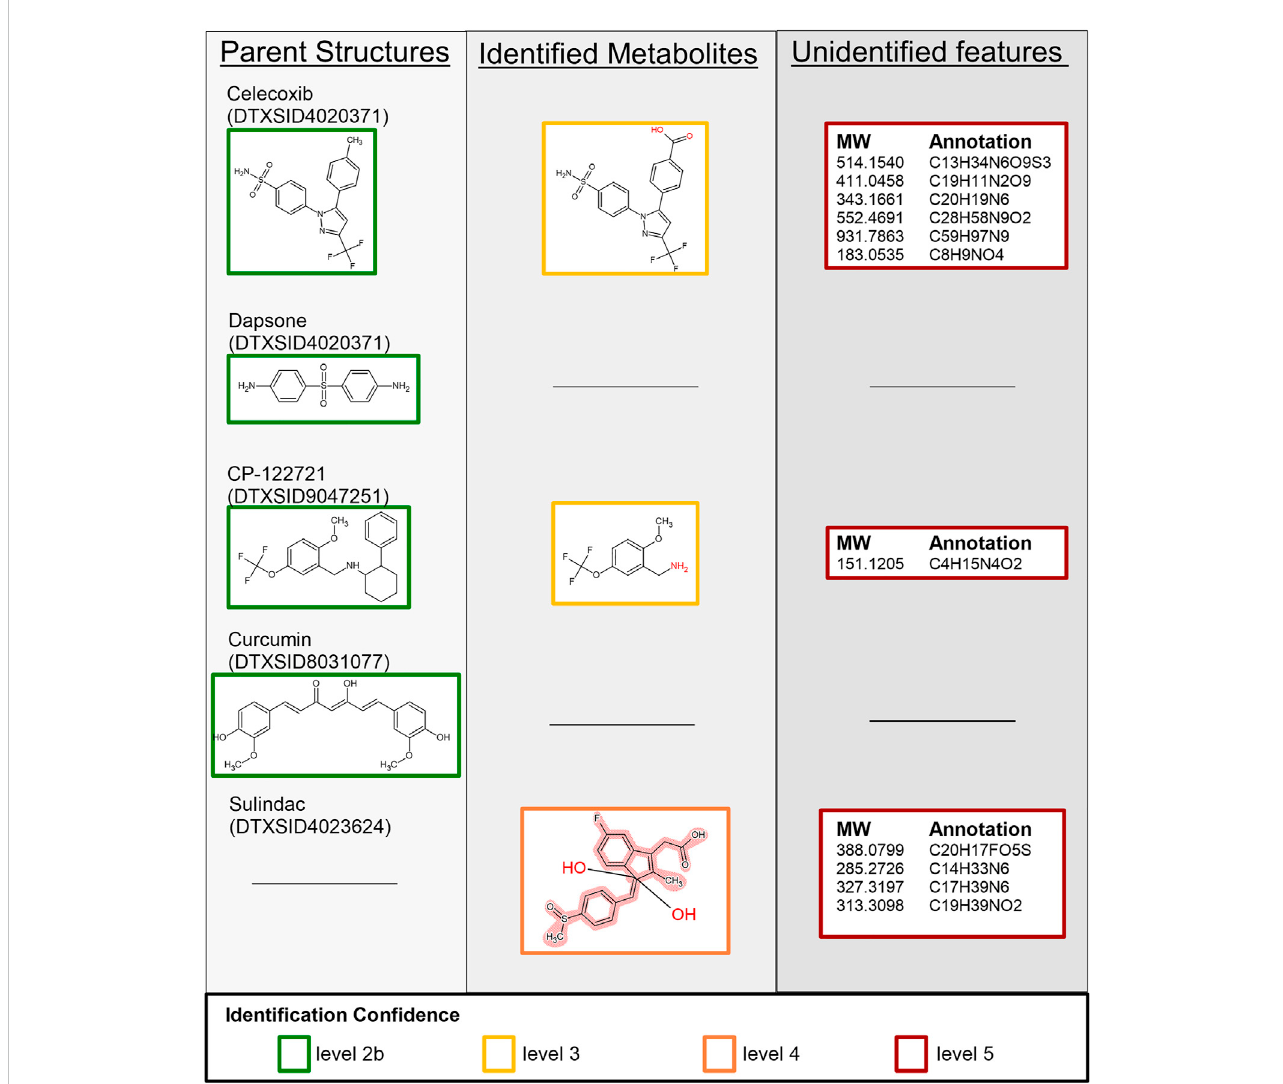
FIGURE 6 Summary of identi fi edand unidenti fi edfeatures extracted from the MS 1 and MS 2 data for celecoxib, dapsone,CP-122721, curcumin, and sulindac. Boxes surrounding individual structures denote the level of con fi dence in that assignment as described in Section 2.5.4, and the black line indicates that no features wereidenti fi ed to correspond to the respective row and column. BecauseSSA isnot optimizedfor any one compound, our work fl ow relied on occurrence of chemical signals in replicate samples and time-correlated changes in signal to fi lter the signals. In some cases, real chemical detections may have been lost. For example, no features were identi fi ed that corresponded to the sulindac parent structure but multiple isomeric sulindac metabolites are represented with a Markush structure. Unidenti fi ed features include the molecular weight (MW) and formula